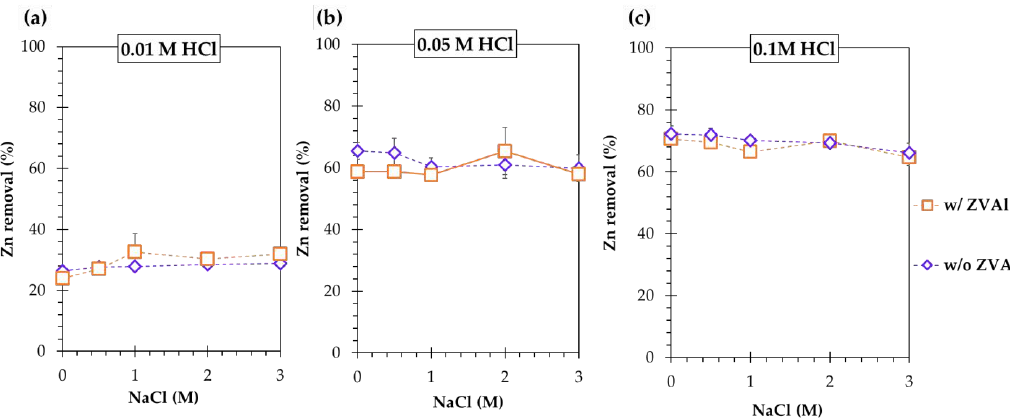
Figure 12. Effects of solution compositions on Zn removal from ZPLRs with and without ZVAl addition: ( a ) 0.01 M HCl and 0–3 M NaCl, ( b ) 0.05 M HCl and 0–3 M NaCl, and ( c ) 0.1 M HCl and 0– 3 M NaCl.